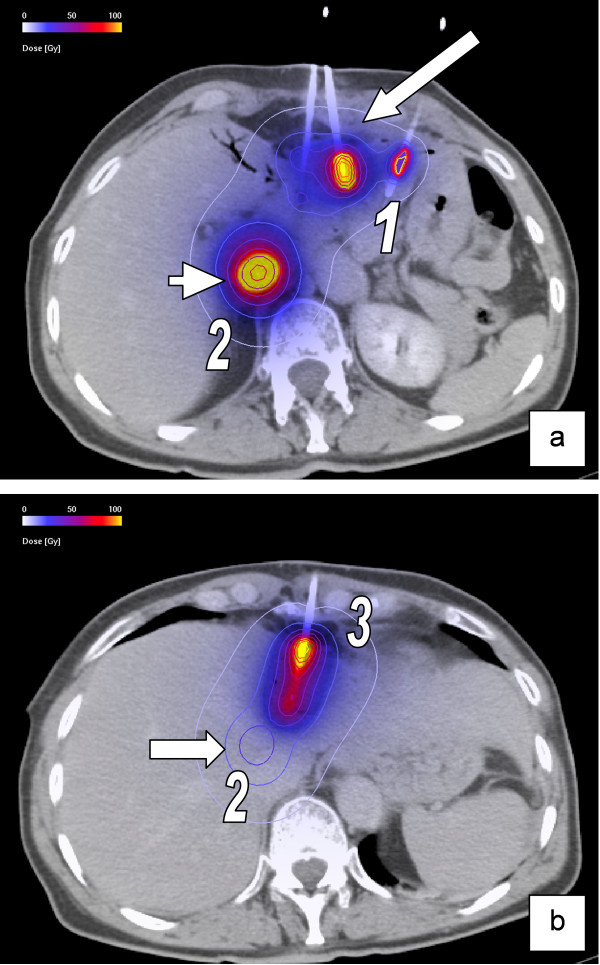
Image fusion of CT-data set with the accumulated 3-D dosimetry of three different irradiation sessions. (a) Contrast-enhanced CT after first (No.1) CT-guided positioning of brachytherapy catheters (long arrow) in metastases of a colorectal carcinoma. The short arrow shows the 3-D dosimetry of another lesion, irradiated in session No.2. (b) Contrast-enhanced CT after third intervention (No.3) in the same patient. The arrow shows the upper boundary of the 3-D dosimetry of the lesion irradiated in session No.2. Physical doses are shown in the colour map.